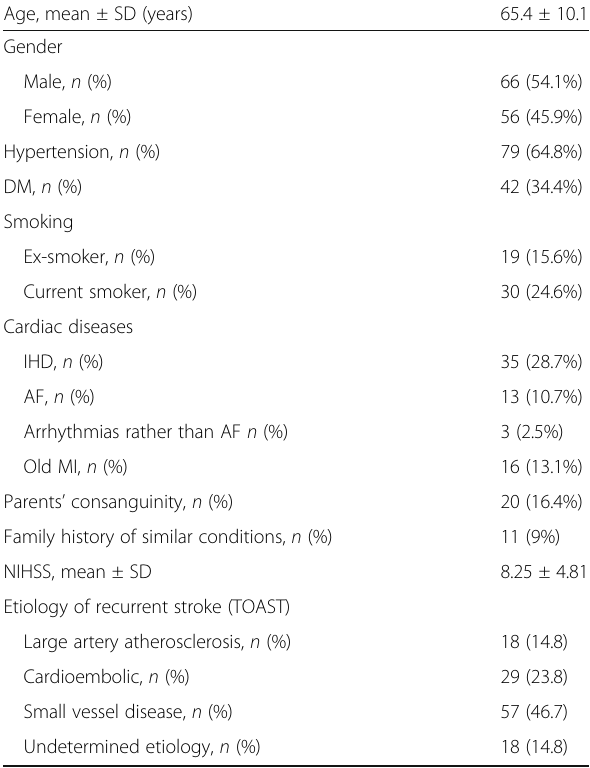
Fig. 1 Flow chart of the patients admitted during the study period Table 1 Baseline characteristics of the patients included in the analysis